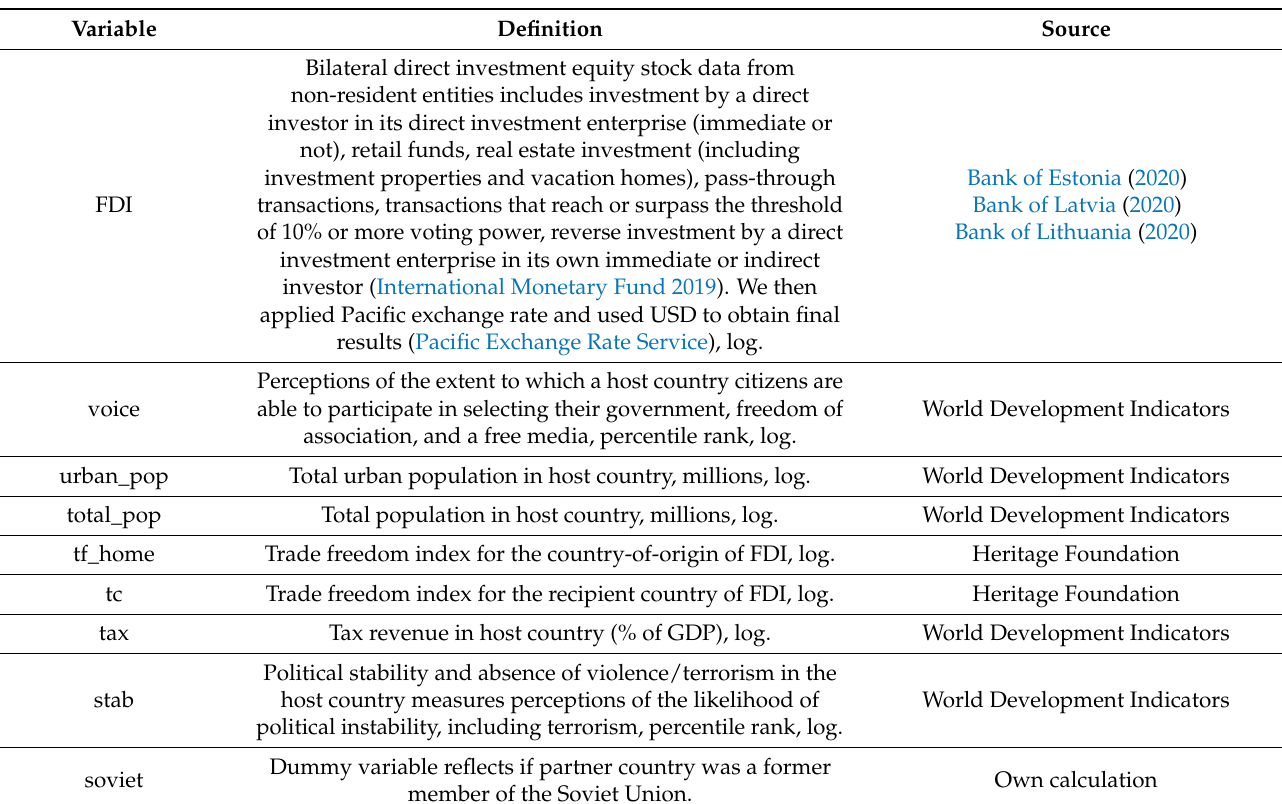
Table A4. Variables used in the